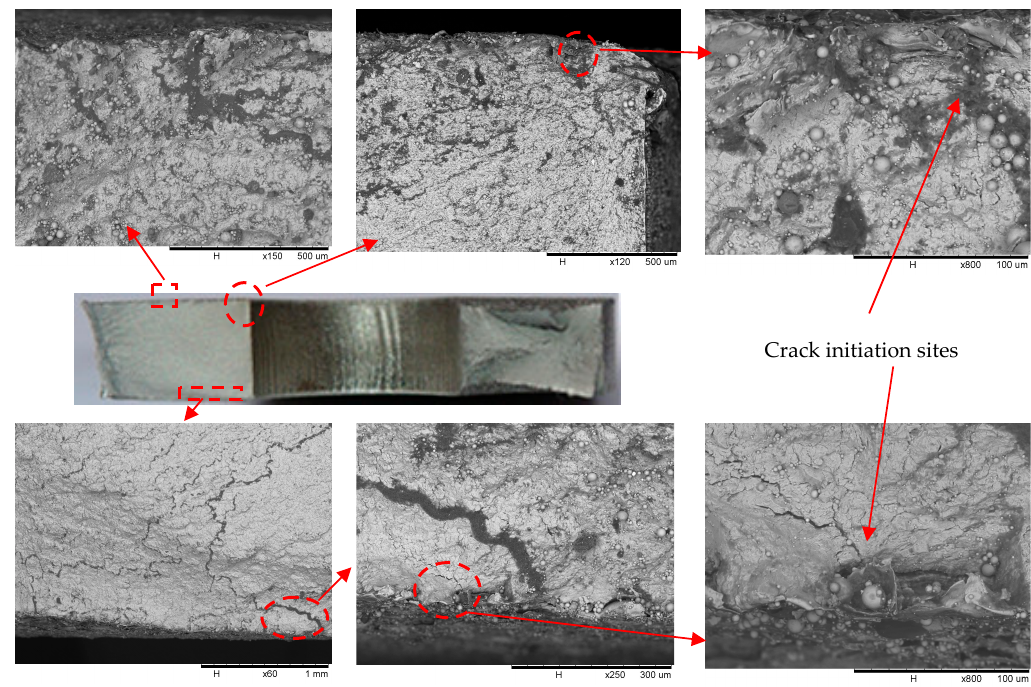
Figure 2. Typical fracture surface for test specimen ( Δσ = 210 MPa).